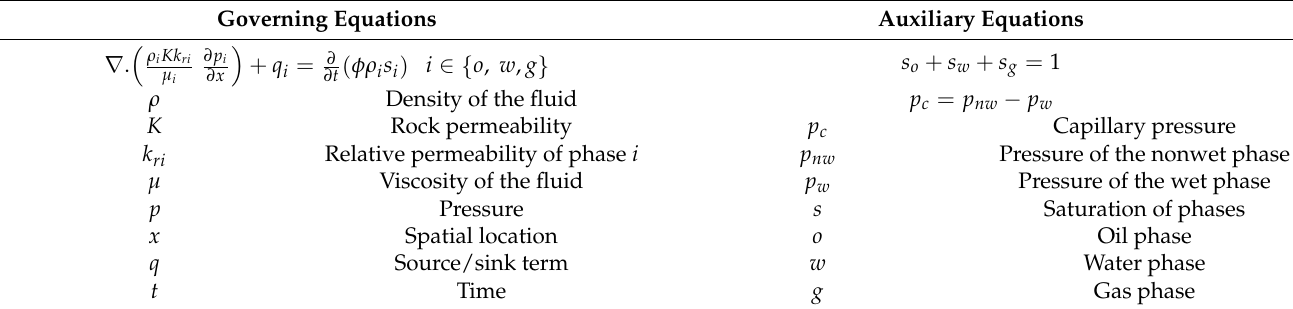
Table 1. Description of governing and auxiliary equations parameters (Equations (1)–(3)). Governing Equations Auxiliary